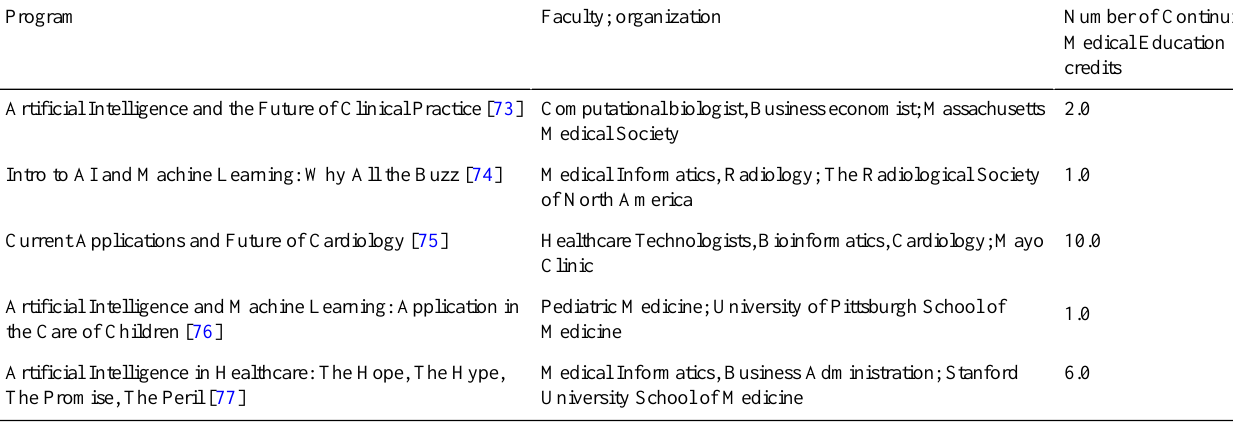
Table 2. List of Continuing Medical Education programs on artificial intelligence in health